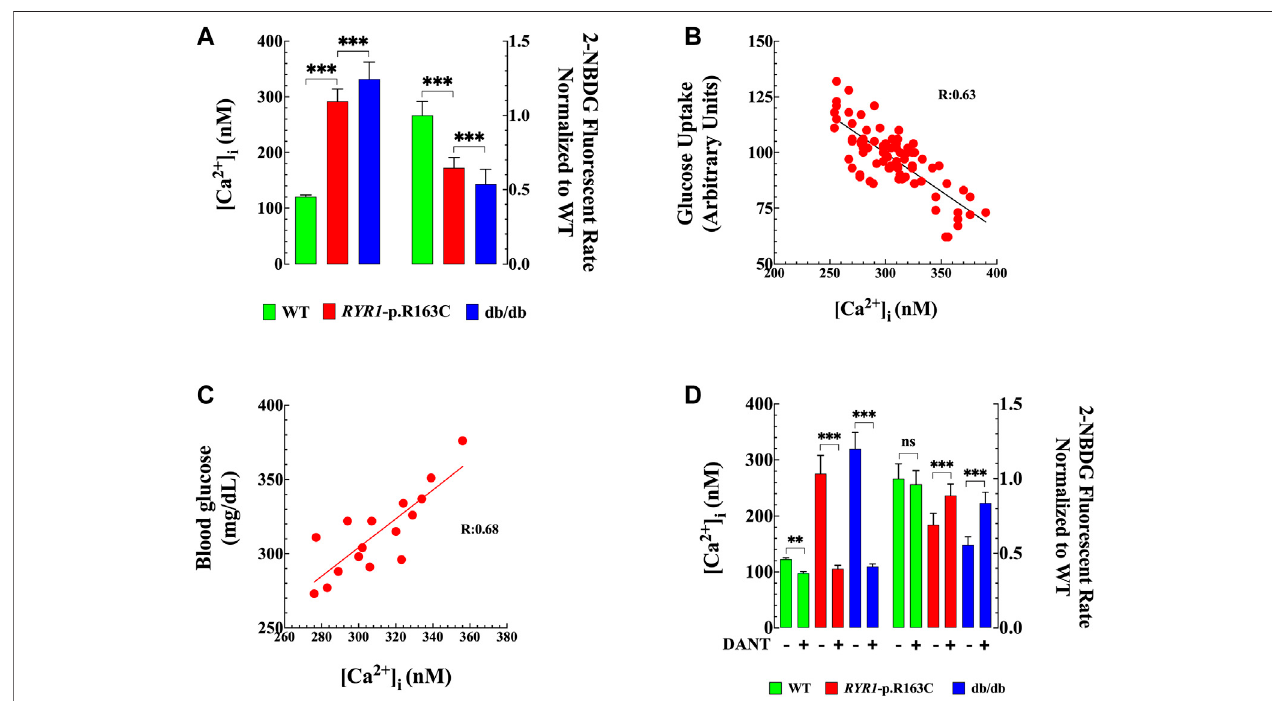
FIGURE 5 | Increased [Ca 2+ ]i impairs glucose uptake in muscle fi bers. [Ca 2+ ] i and glucose uptake were recorded simultaneously in vivo in intact gastrocnemius fi bers WTand RyR1 -p.R163Canddb/dbusingdouble-barreled selectiveCa 2+ microelectrodesandthe2-NBDG fl uorescentglucoseanalog. (A) Leftpanel:Intracellular [Ca 2+ ]washigherin RYR1 -p.R163Canddb/dbthanintheWTmuscle.Rightpanel:Glucoseuptakewassigni fi cantlyreducedin RYR1 -p.R163Canddb/dbcomparedto WTmuscle.All fl uorescencesignalswerenormalizedtoWT. (B) Apositivecorrelationbetweenmuscleglucoseuptakeand[Ca 2+ ] i wasfoundin RyR1 -p.R163Cand db/db(R=0.63).Anincreaseinmuscle[Ca 2+ ] i causedadecreaseinglucoseuptake. (C) Showapositivecorrelationanalysisbetweenmice ’ sbloodglucose(mg/dL)and muscle[Ca 2+ ] i (nM)(R=0.68).Increasedmuscle[Ca 2+ ] i causedamoreelevatedbloodglucoseconcentration. (D) Leftpanel:[Ca 2+ ] i waselevatedin RYR1 -p.R163Cand db/db compared to WT muscle. Dantrolene treatment signi fi cantly reduced [Ca 2+ ] i and all genotypes. Right panel: insulin-dependent glucose uptake was reduced in RYR1 -p.R163Canddb/dbcomparedtoWTmuscle.Dantroleneimprovedglucoseuptakeinthe RYR1- p.R163Canddb/dbmuscles,withnosigni fi canteffectinWT.All fl uorescence signals were normalized to WT. The results represent the mean ± S. D from n – 52/genotype group , isolated from n – 6 per genotype; n cells = 14 mice = 5 cells = 14 – 52/genotype group. Statistical analysis was performed as described above. ** = p < 0.01; *** = p < 0.001.